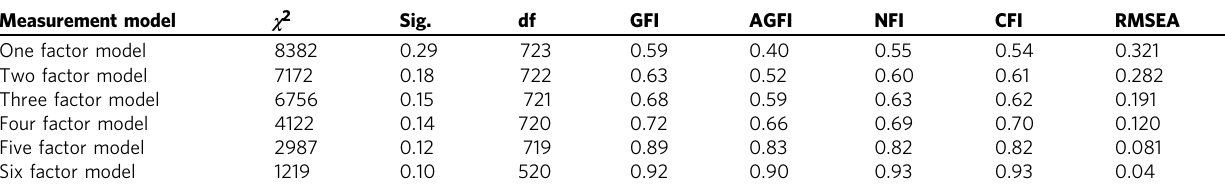
Table 2 Measurement model con fi rmatory factor analysis.